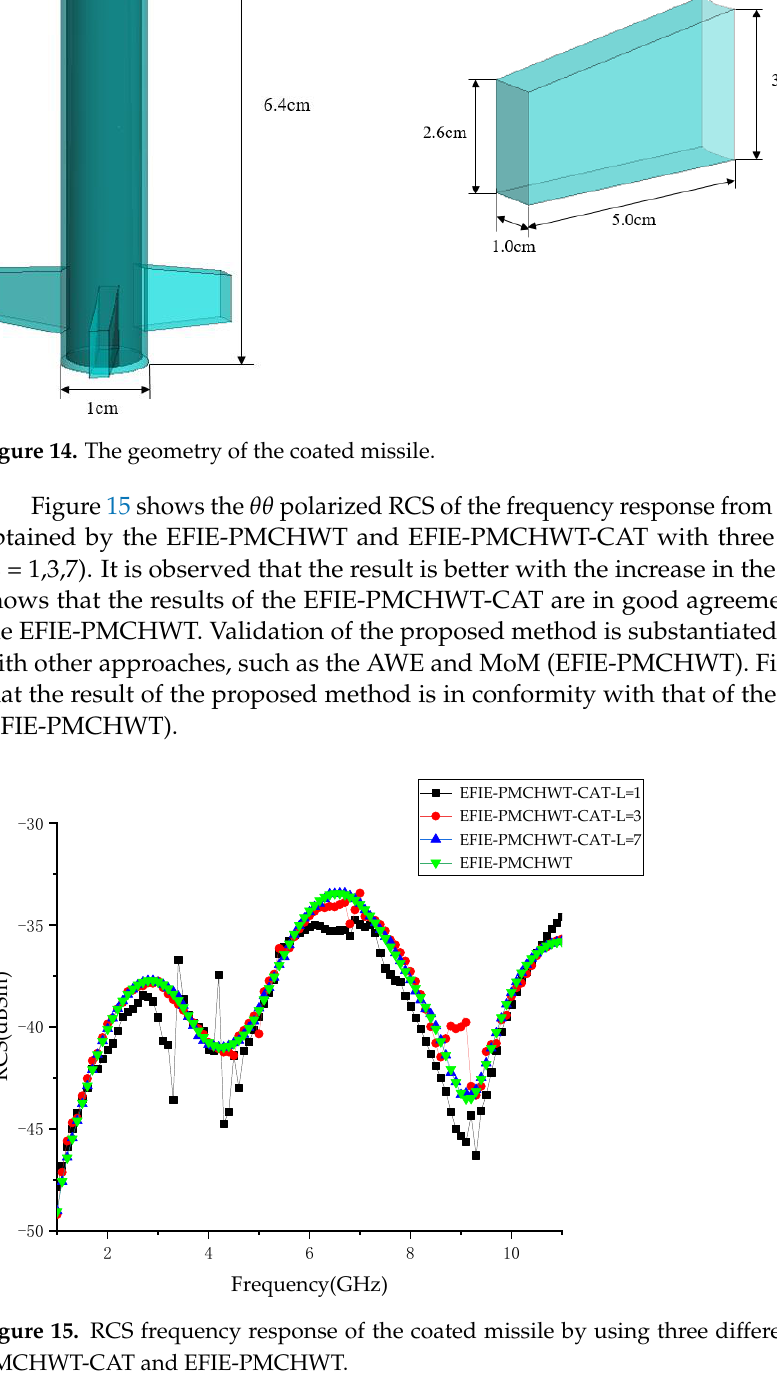
Figure 16. RCS frequency response of the coated missile of the MoM (EFIE-PMCHWT), AWE, and EFIE-PMCHWT-CAT. Using three examples, we found that the result is more accurate with a higher-order L. The reason is that the Chebyshev – Gauss sampling frequency points store more infor- mation on the currents. When the order L is low, Equations (28) and (29) show fewer